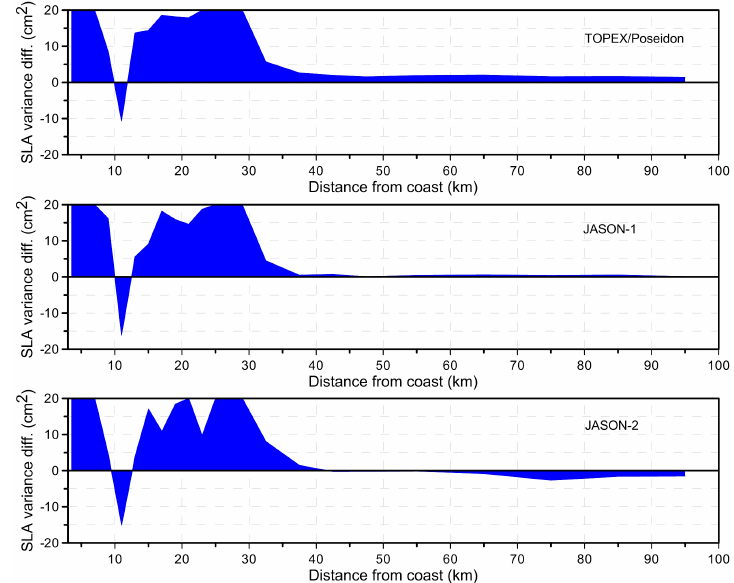
Figure 19. SLA variance differences (cm 2 ) function of distance from the coast between DTU13 and CNESCLS2011 MSS models for TOPEX/Poseidon cycles 1 to 364, Jason-1 cycles 1 to 259 and Jason-2 cycles 1 to 280. Remote Sens. 2017 , 9 , 102